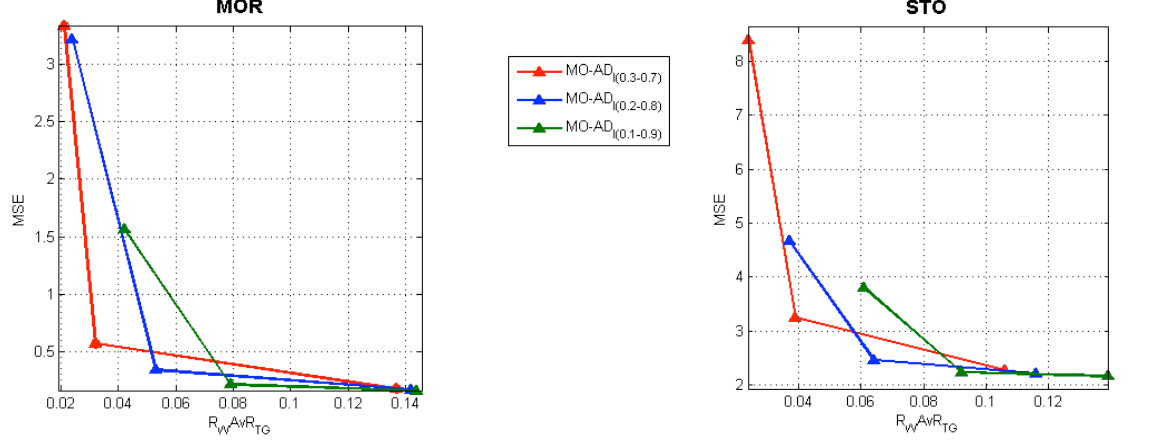
Fig. 2. Average Pareto fronts obtained for STO and MOR problems in the accurate-interpretability plane for